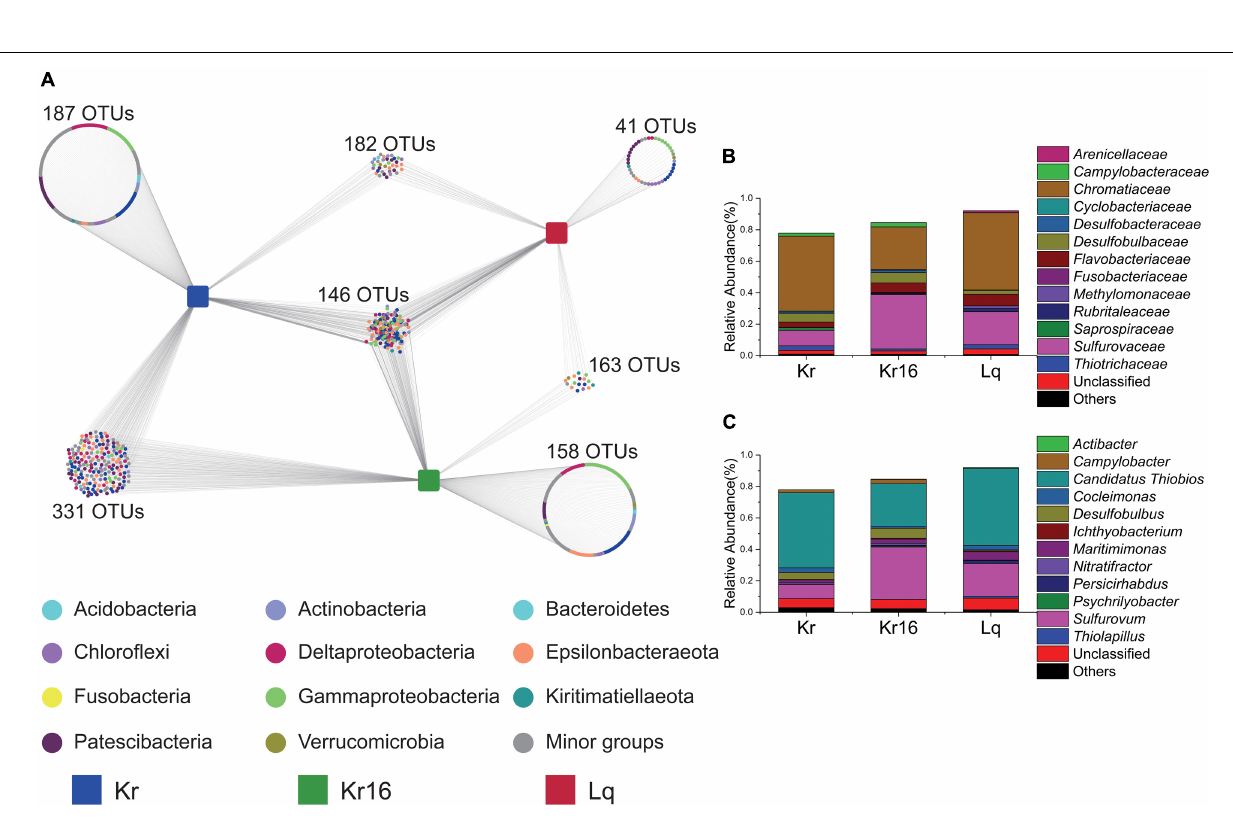
Frontiers in Marine Science |